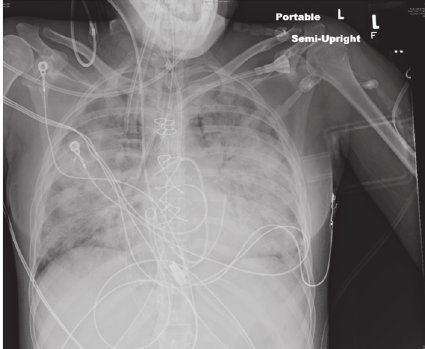
Figure 6: Repeat chest X-ray after intubation shows worsening bilateral aeration with developing patchy infiltrates.